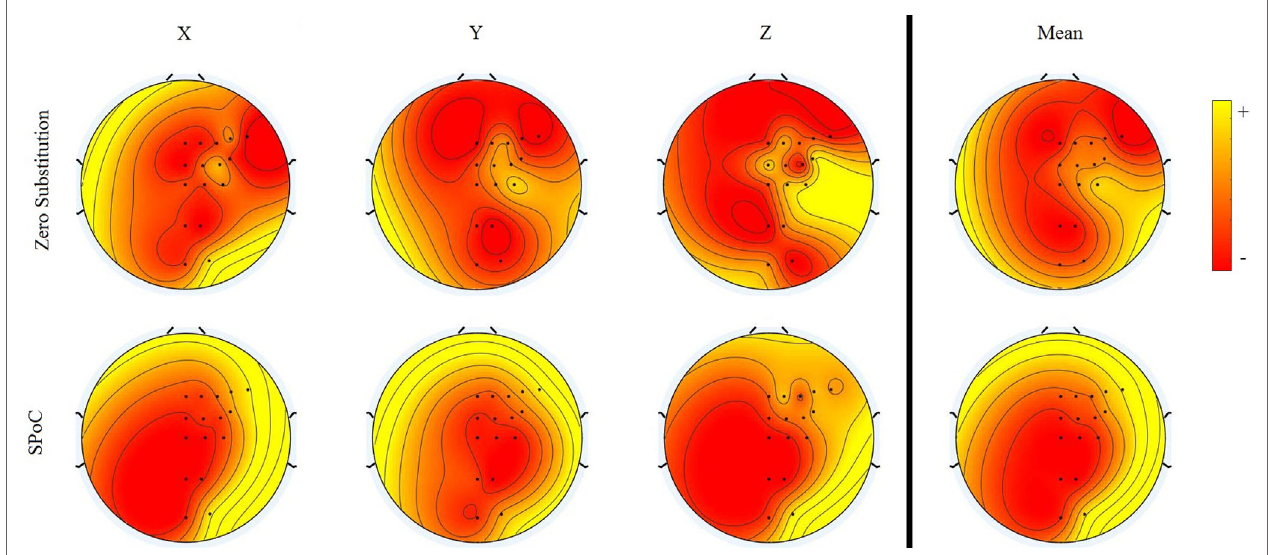
FigUre 8 | Topographical representation of the variable importance for two different methods . For each method, the importance for the three dimensions and the mean are presented. Each of the methods has different scales. Therefore, the colors in the map are relative to each